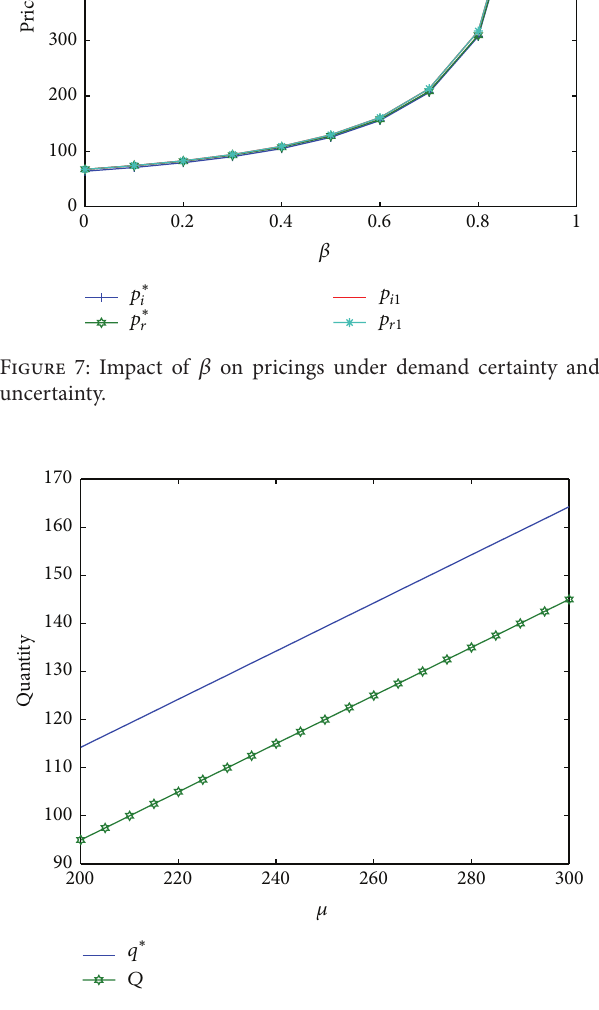
Figure 8: Impact of 𝜇 on ordering quantity under demand certainty and